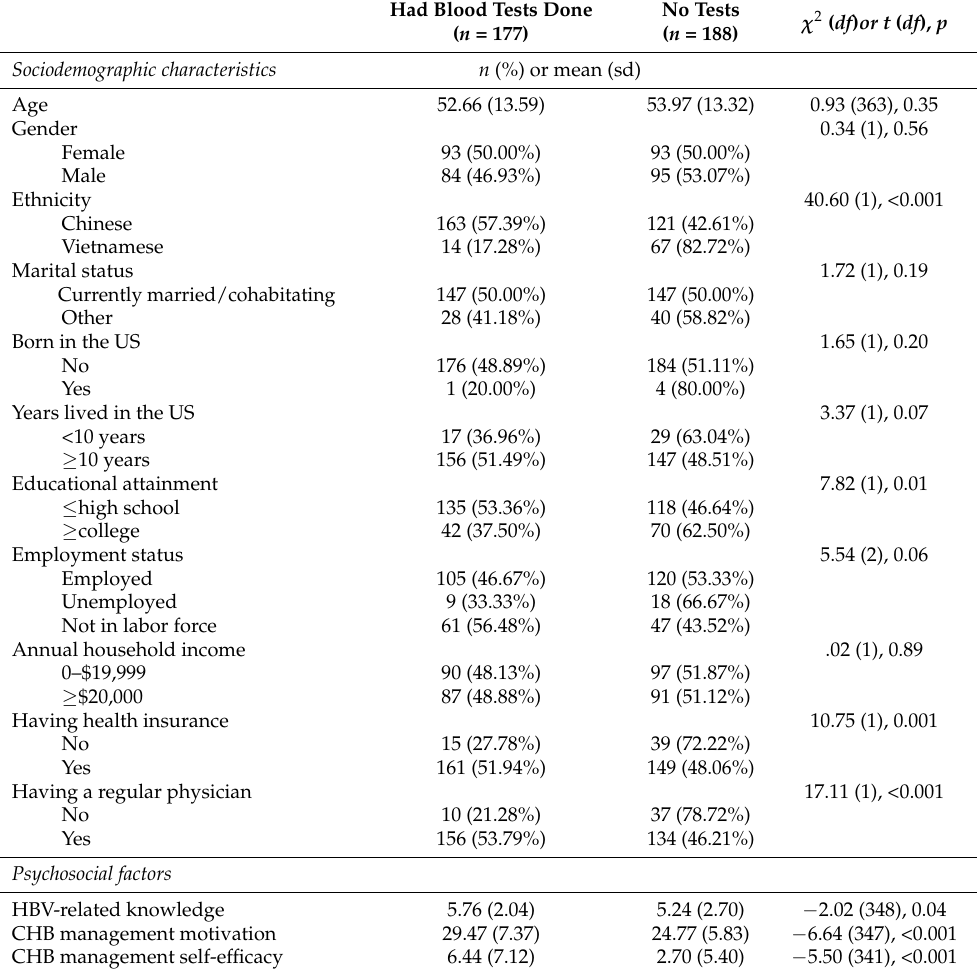
Had Blood Tests Done No Tests χ 2 ( df ) or t ( df ), p ( n = 177) ( n = 188)